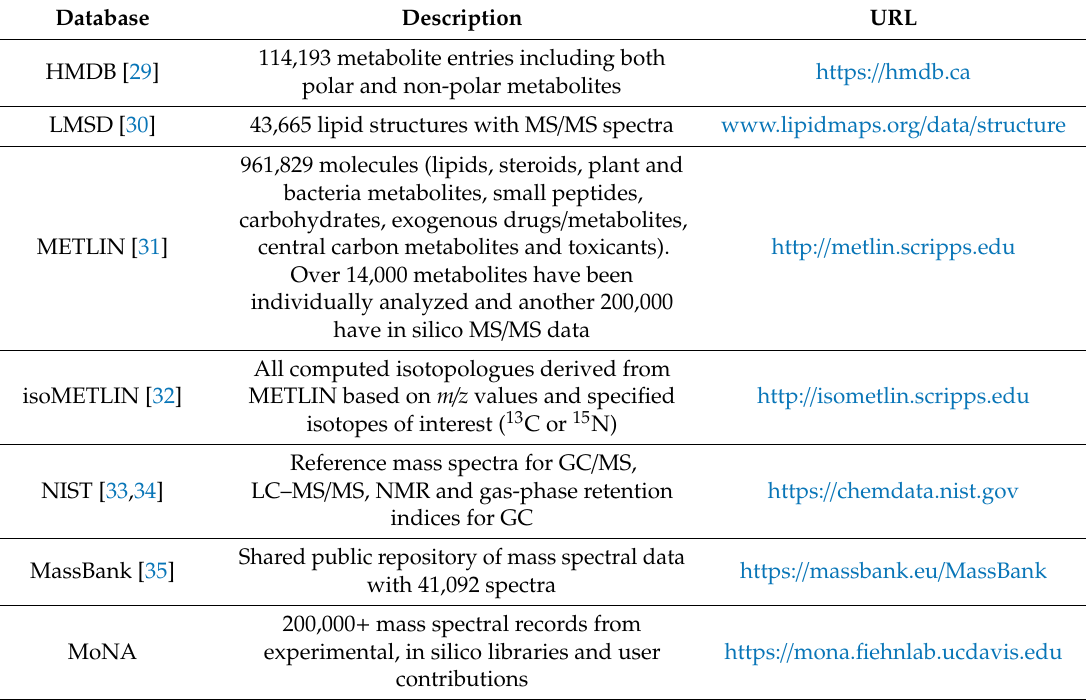
Table 2. Available spectral database for metabolite annotation